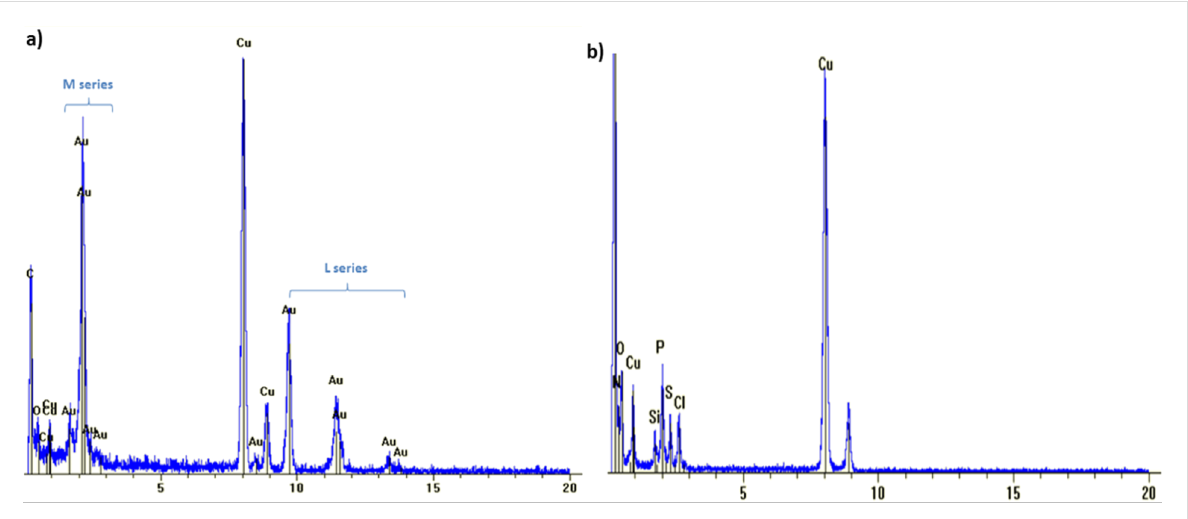
Figure 4: EDX spectra (a) for the gold nanoparticles and (b) for the background. The copper comes from the grid used during the experiments.